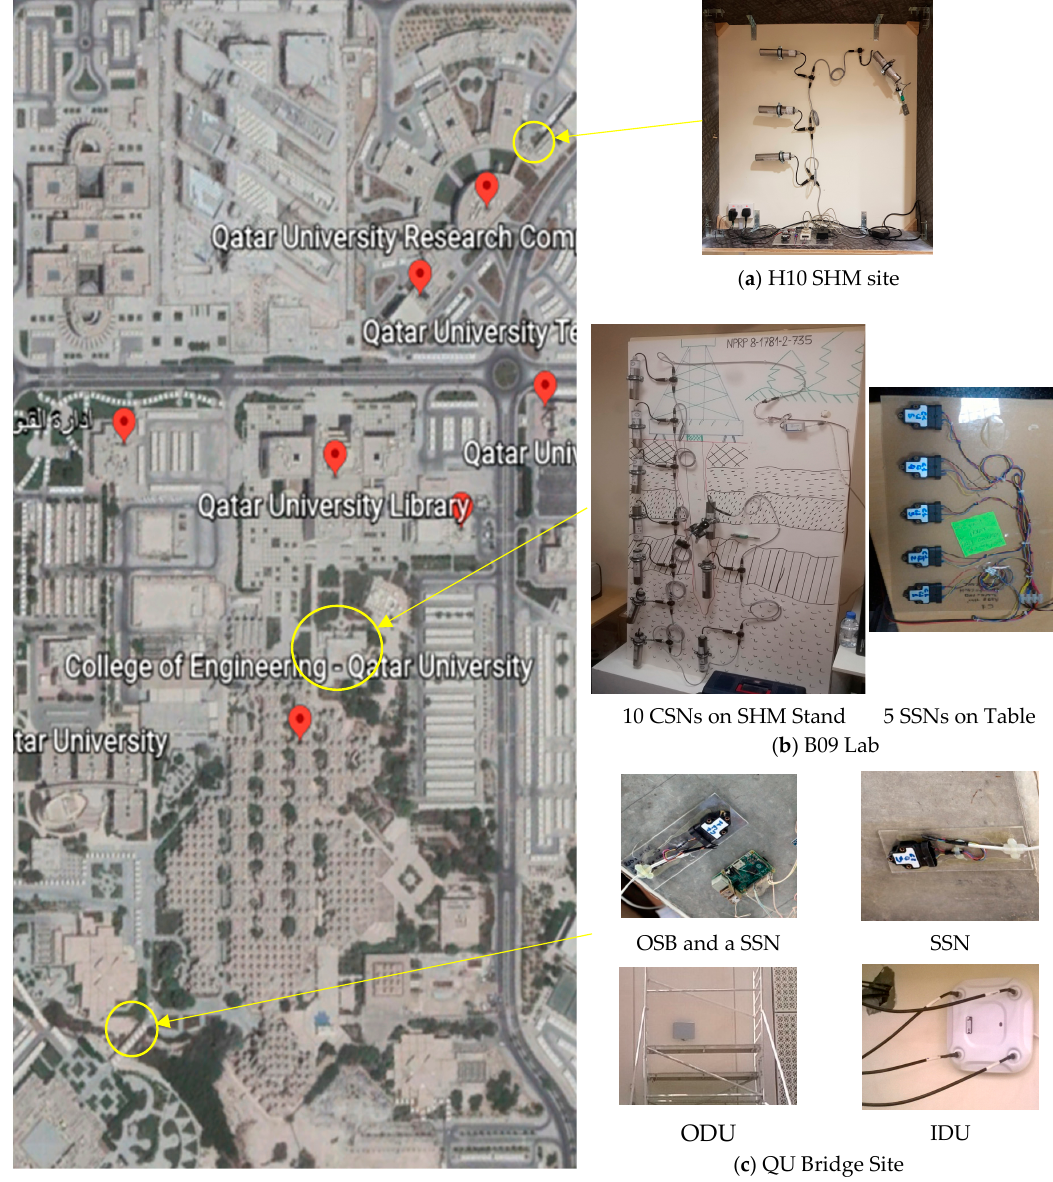
Figure 9. Case Study: QU SHM Sites Deployment Details ( a – c ).